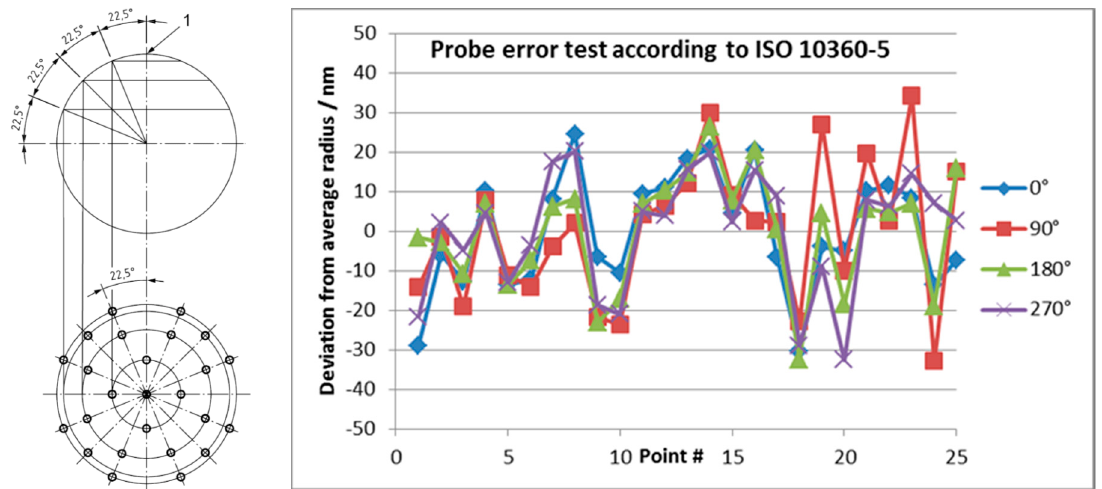
Figure 4. Determination of the single point probing error according to ISO 10360-5 on a 1 mm Si 3 N 4 sphere: ( left ) Arrangement of probing points on the reference sphere; ( right ) Deviation from average radius for four measurements with sphere rotated by 90 ˝ .